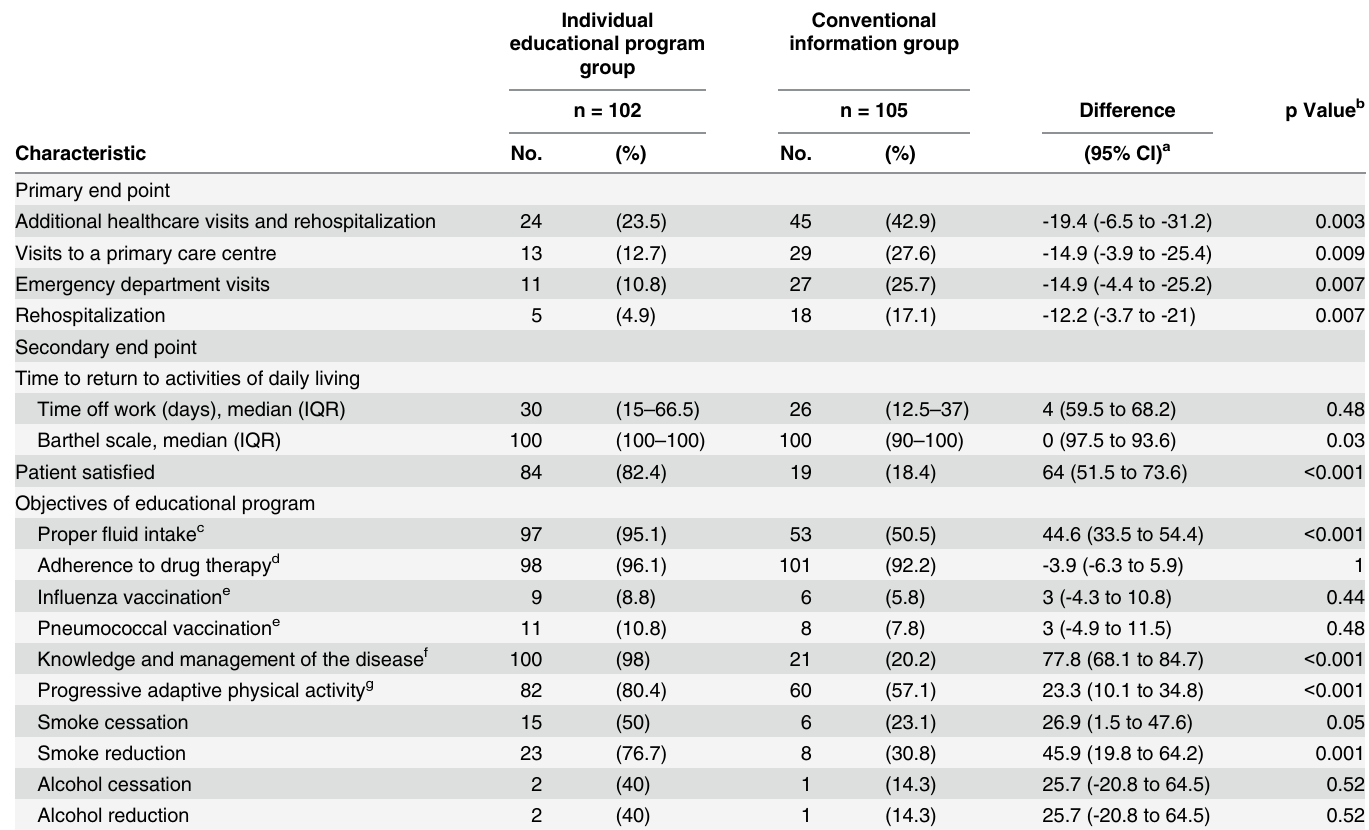
Table 2. Outcomes for study patients by treatment group. Abbreviations: IQR, interquartile